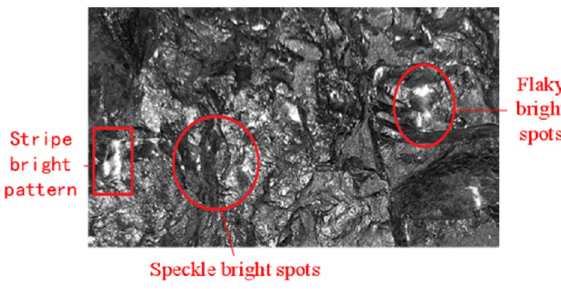
Figure 6. Bright spots formed by reflection on coal